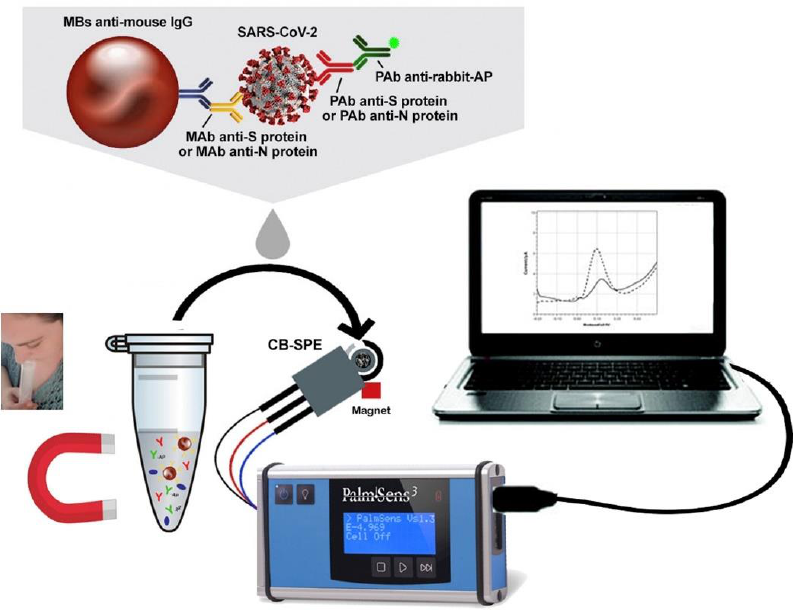
Figure 12. The MBs-based assay for SARS-CoV-2 detection in untreated saliva. Reprinted with per- mission from Elsevier from Ref. [152]. permission from Elsevier from Ref.